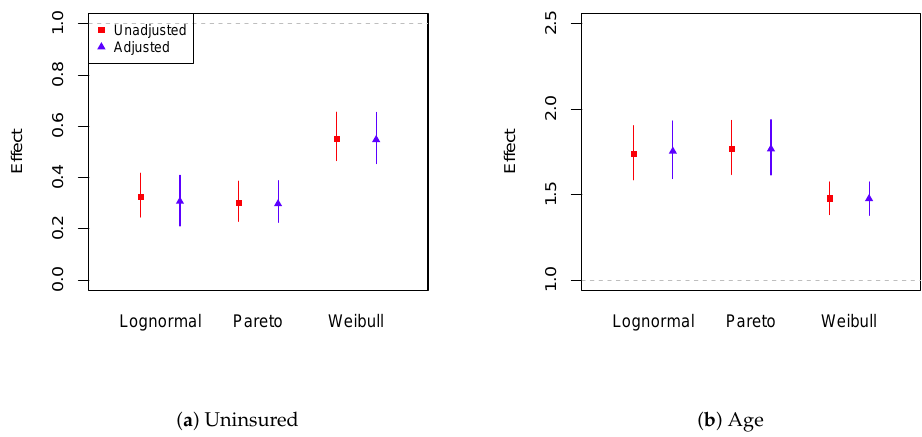
Figure 7. Credible intervals for the relativity of uninsured status and age, exp ( α 1 ) and exp ( α 2 ) , for the heavy-tailed models on the total medical expenditures. The age effect corresponds to the increase of age by one standard deviation (i.e., SD = 12 years).